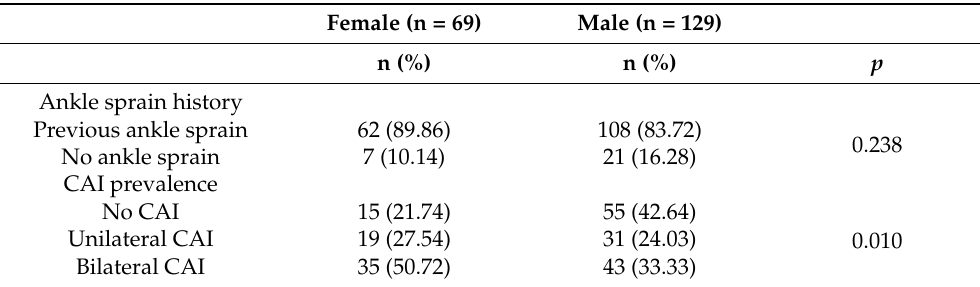
No CAI Bilateral CAI 43 (33.33) CAI: chronic ankle instability (meeting the IAC criteria, including the CAIT cut-off value in those with previous ankle sprains). For foot and ankle characteristics, 206 ankles meet the IAC criteria (left: 100; right: 106); their means (SD) of navicular drop distance were 0.39 (0.17) cm and 0.41(0.19) cm for left and right, respectively, while for toe–wall distance they were 11.40 (3.00) cm and 12.01 (3.37) cm for left and right, respectively. In those 190 ankles which did not meet the CAI inclusion criteria (left: 98; right: 92), for navicular drop distance they were 0.42 (0.18) cm and 0.42 (0.19) cm for left and right, respectively, and for toe–wall distance they were 11.51 (3.50) cm and 11.94 (3.28) cm for left and right, respectively. There was no significant difference in the navicular drop tests between the ankles that did and did not meet the CAI inclusion criteria (left: p = 0.12; right: p = 0.68, Figure 2), or in the dorsiflexion ranges (toe–wall distance) (left: p = 0.82; right: p = 0.88, Figure